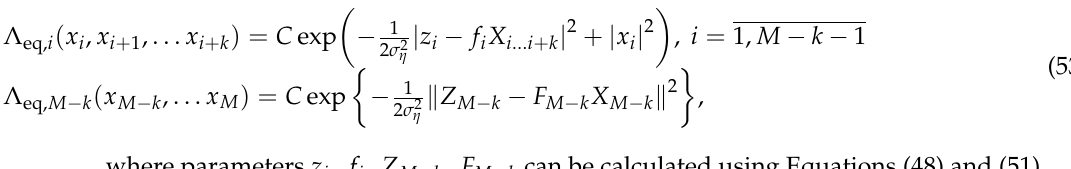
Figure 2. Generalized block diagram of a MIMO demodulation algorithm using an MMSE detector for factorization or MIMO channel matrix sparsification.